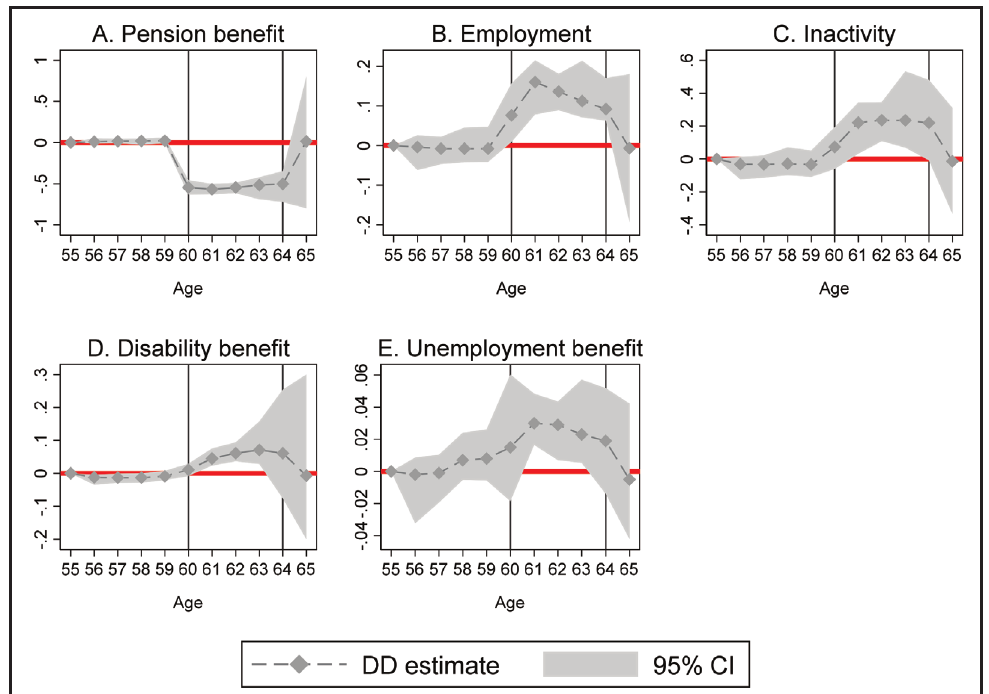
Figure 3 Effect of raising the NRA on different labor market outcomes at every single age (Ages before, during, and after the NRA